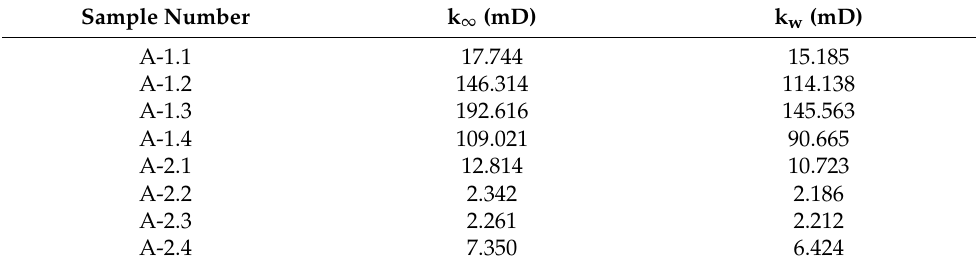
Klinkenberg-corrected permeability and water permeability values of PETRONS core